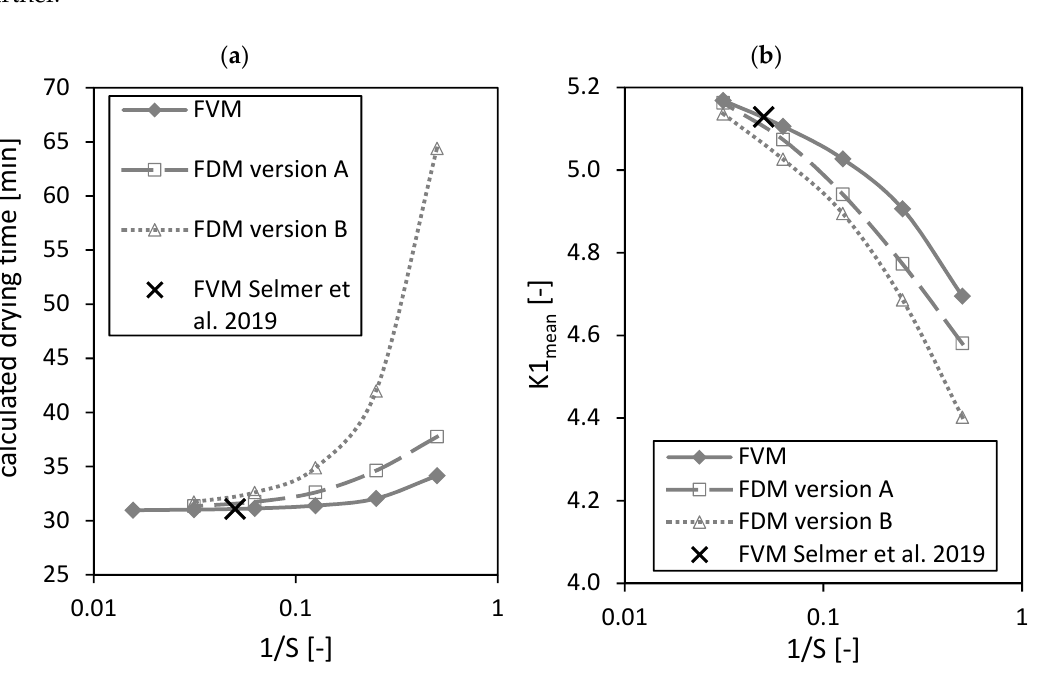
Figure 7. Calculated drying time ( a ) and dimensionless number K 1 mean ( b ) calculated by the FVM, FDM version A and B and the FVM, with the settings used in Selmer et al. 2019 [3] depending on the reciprocal of the number of nodes S using x start REF 2,f = 0.05. Calculation settings: N = 26, S REF = 64, Δ t = 0.05 s (for FVM, FDM version A and B), Δ t = 0.1 s (for FVM Selmer et al. 2019 [3]), S = 20 (for FVM Selmer et al. 2019 [3]).